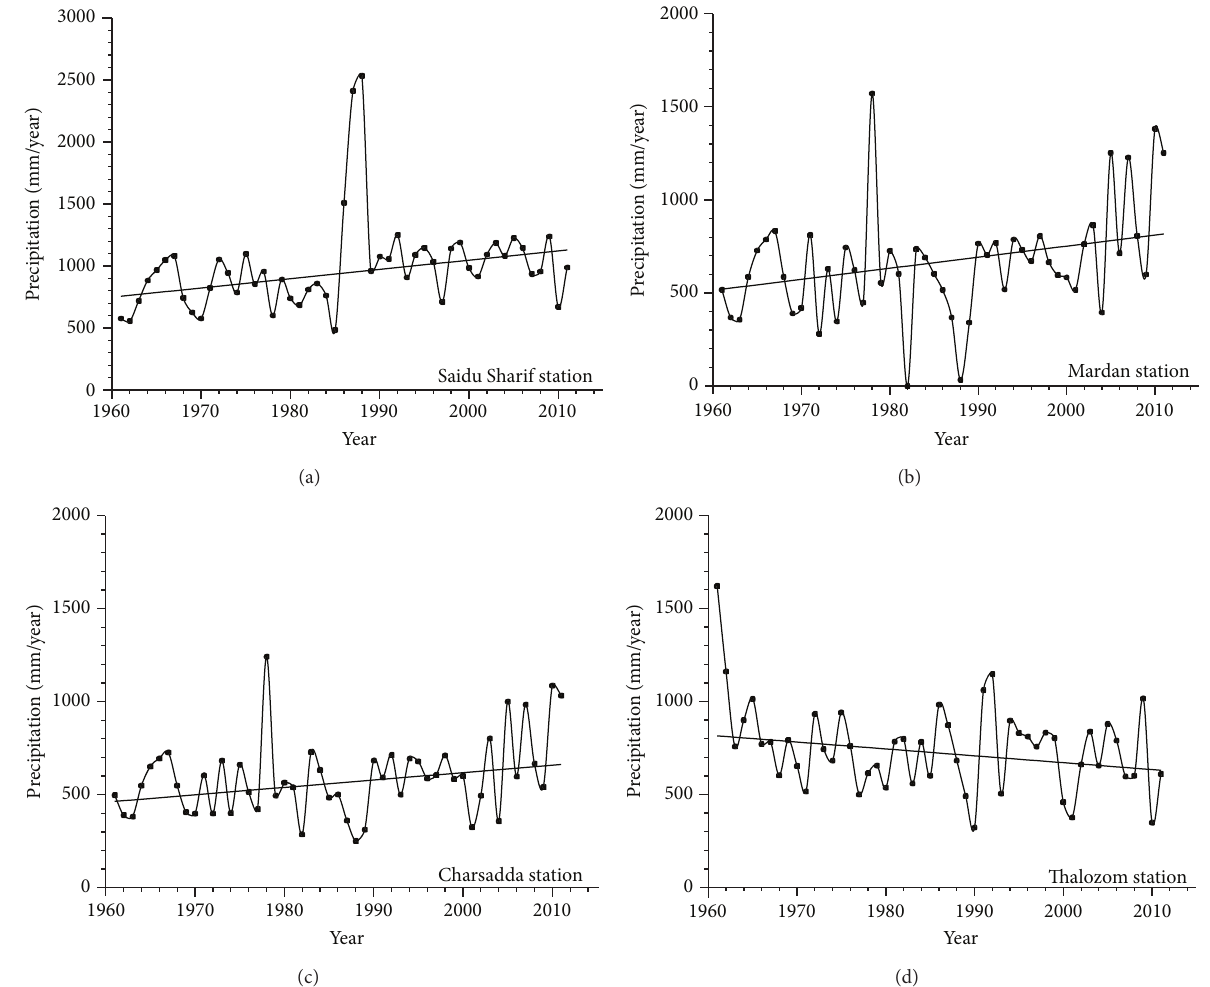
Figure 6: Variations of annual precipitation time series in stations with significant trends during